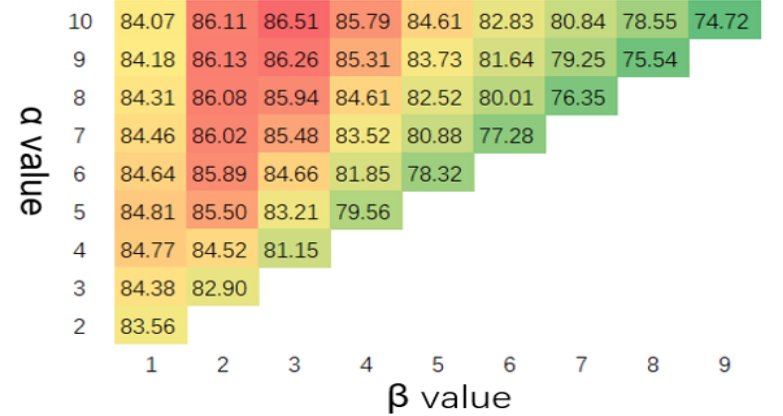
Figure 6. False alarm rate(%) with different values of α and β (scanning period = 128 and channel width = 20).